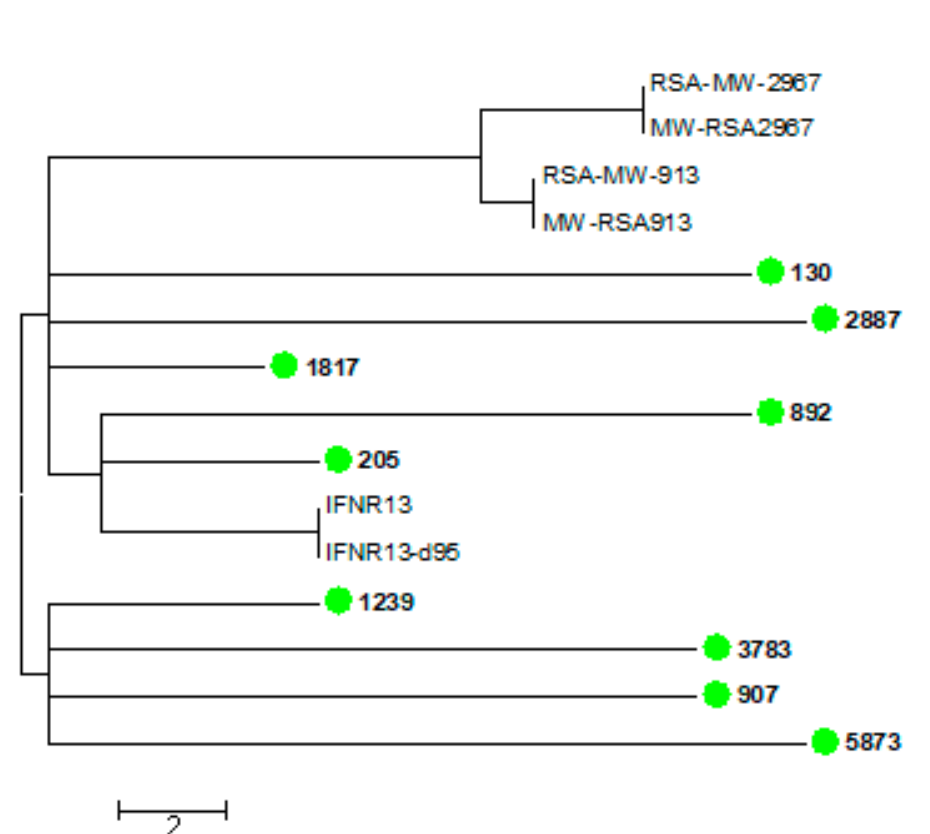
Figure 5. WGS SNP analysis of 15 South African clinical Cryptococcus neoformans isolates (nine from this study and six from previous South African studies) with the VNB molecular type. Isolates from this study are indicated with green circles and bold. Sample number 1239 was used as the reference for the VNBII clade. BWA was used to align reads to the reference and SAMtools was used to call SNPs. There were 111 SNPs in total with a coverage breadth of 73% and this is an unrooted maximum parsimony tree. The consistency index was 1.00 and the number of phylogenetic sites was 111.